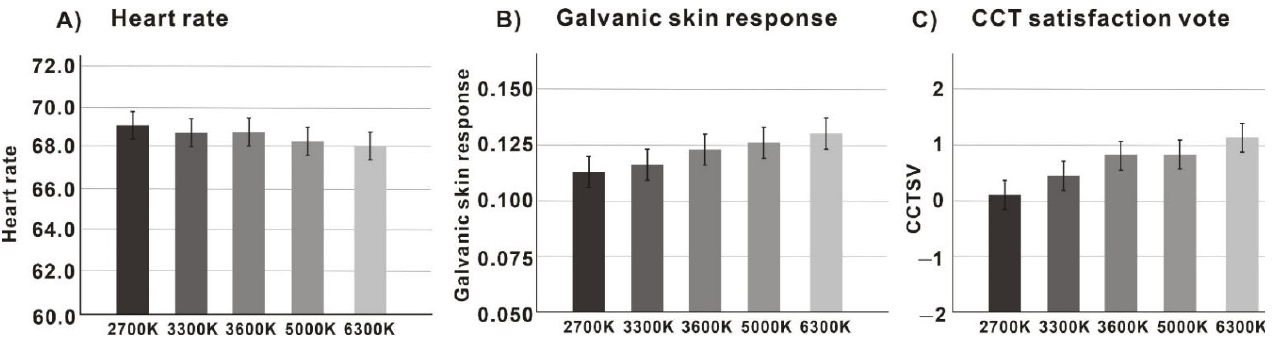
Figure 5. ( A ) Heart rate; ( B ) galvanic skin response; ( C ) CCT satisfaction vote impact in the five CCT conditions (the error bars show the standard error of the means.).